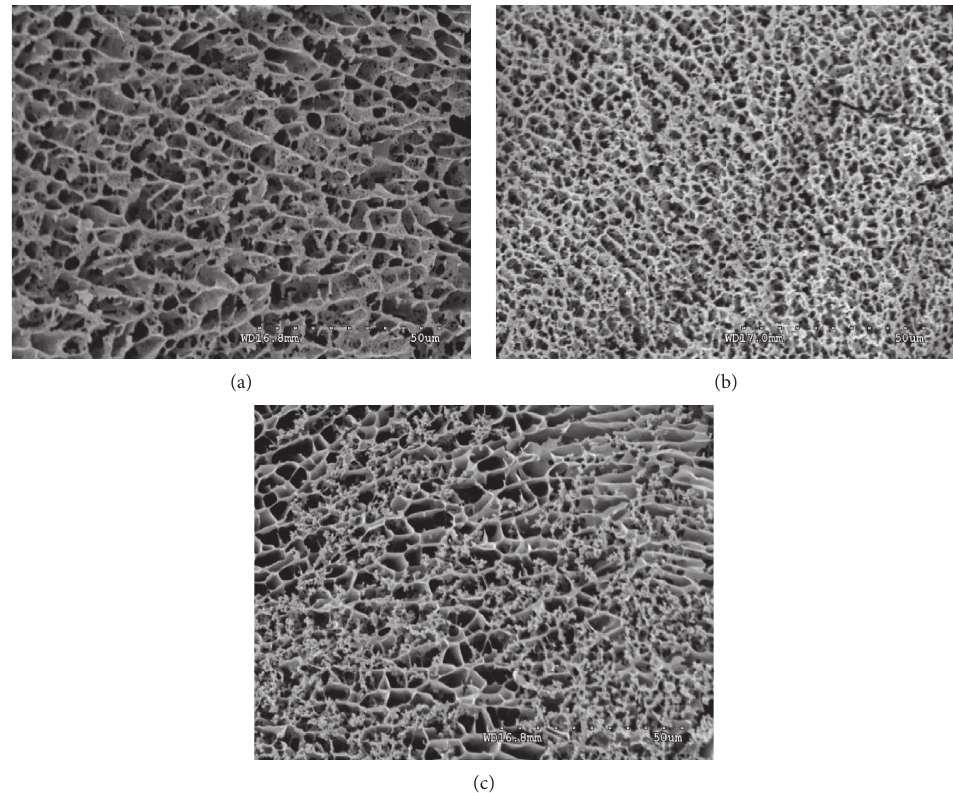
Figure 3: The microstructure of acid-induced yak milk gels prepared from skim yak milk with preheating pH 7.1 and 0 (a), 3 (b), and 10 (c) U TGase per gram